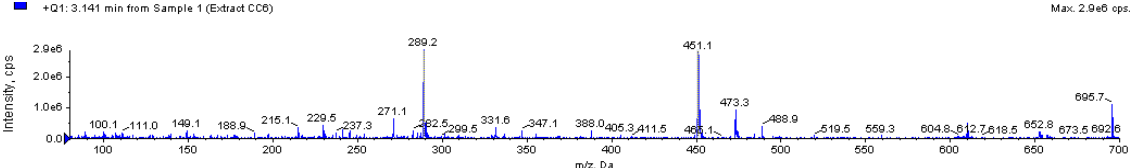
Figure 2. Full scan acquisition window showing the molecular ion [M+H] + =451 at t